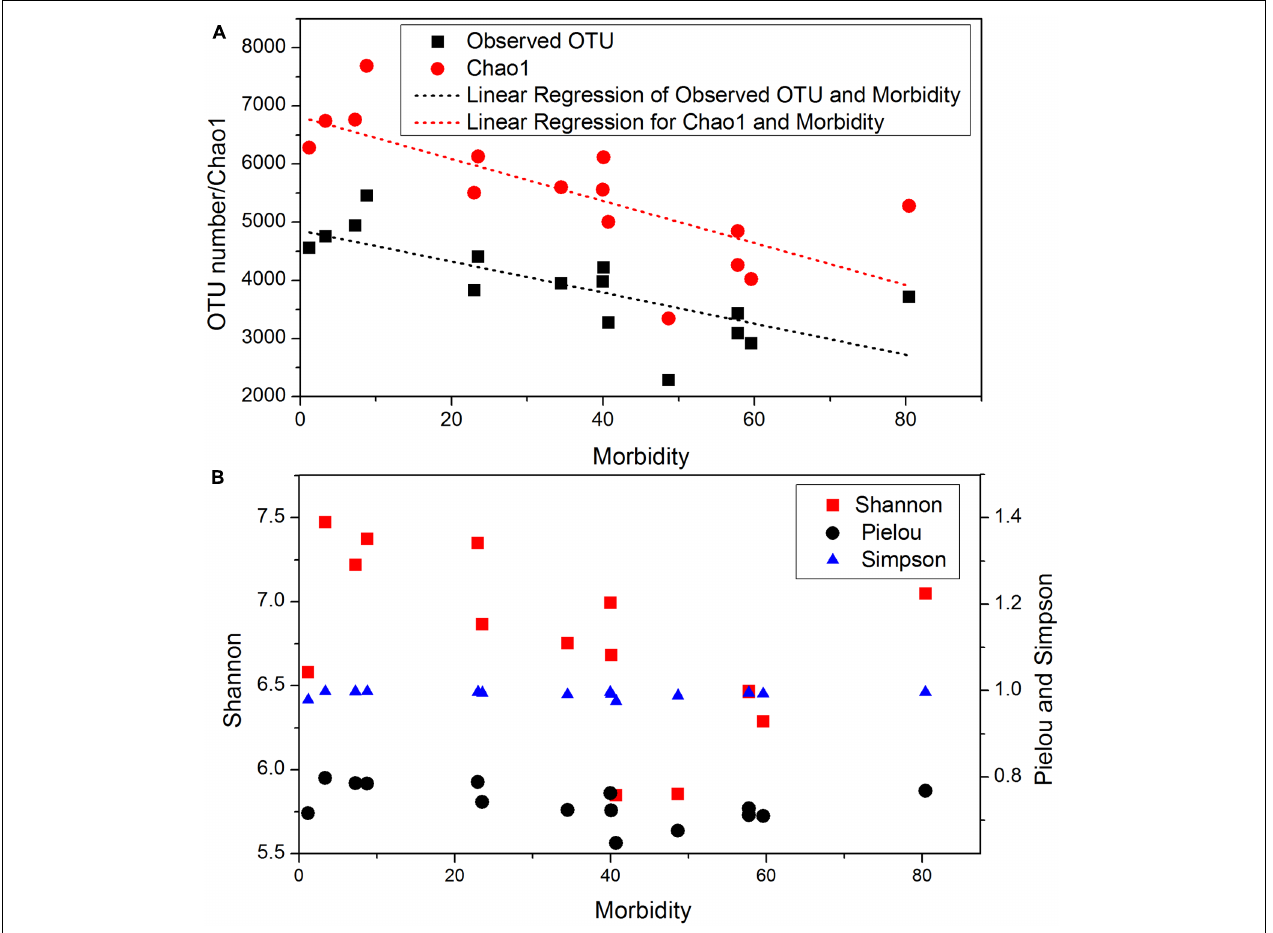
FIGURE 1 | Microbial community diversity in 15 sites with different bacterial wilt infection rate. (A) Observed OTU and Chao1; (B) Shannon, Pielou and Simpson indexes. Linear regressions were present for indexes that significantly ( p -value < 0.05) correlated with infection rate (Morbidity). Pearson correlation indexes and p -values are shown in Supplementary Table